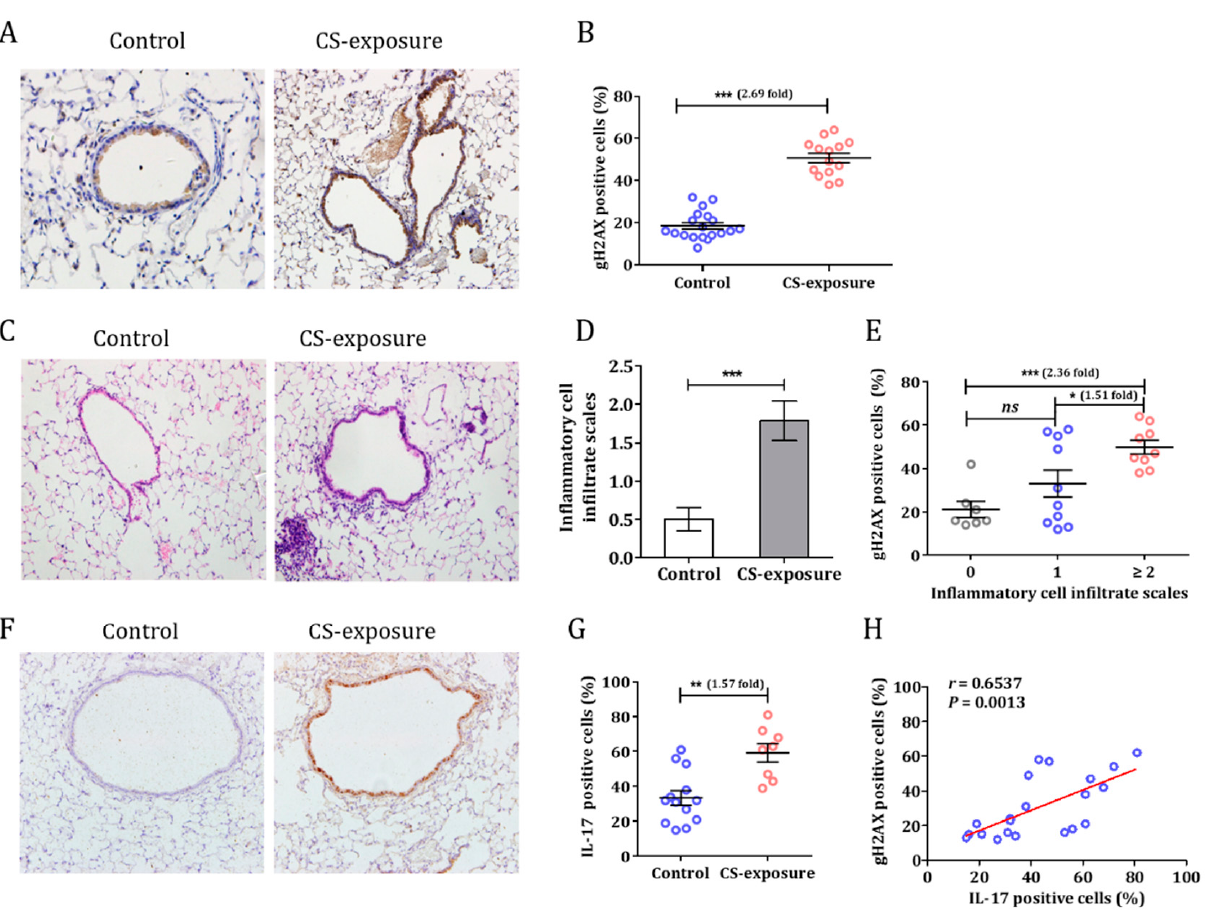
Figure 2. Cigarette smoke induced DDR and airway inflammation in mice. ( A ) C57BL/6 mice were exposed to smoke for 12 weeks and the DDR in lungs was assessed (IHC, gH2AX). ( B ) The percentages of gH2AX-positive cells in control and CS-exposed groups were counted. ( C ) Inflammatory cell infiltration in the lungs of mice after exposure to cigarette smoke. ( D ) Inflammation scores in control and cigarette smoke exposure groups. ( E ) Relationship between inflammation scores and DDR in the mouse lung. ( F ) IL-17 expression in the mouse lung after exposure to cigarette smoke. ( G ) Quantification of IL-17-positive cells in control and cigarette smoke-exposed mice. ( H ) The relationship between IL-17 expression and DNA damage in the lung. (n= 6 mice per group in each experiment. Data are presented as means ± SEM, * p < 0.05, ** p < 0.01, *** p < 0.001).